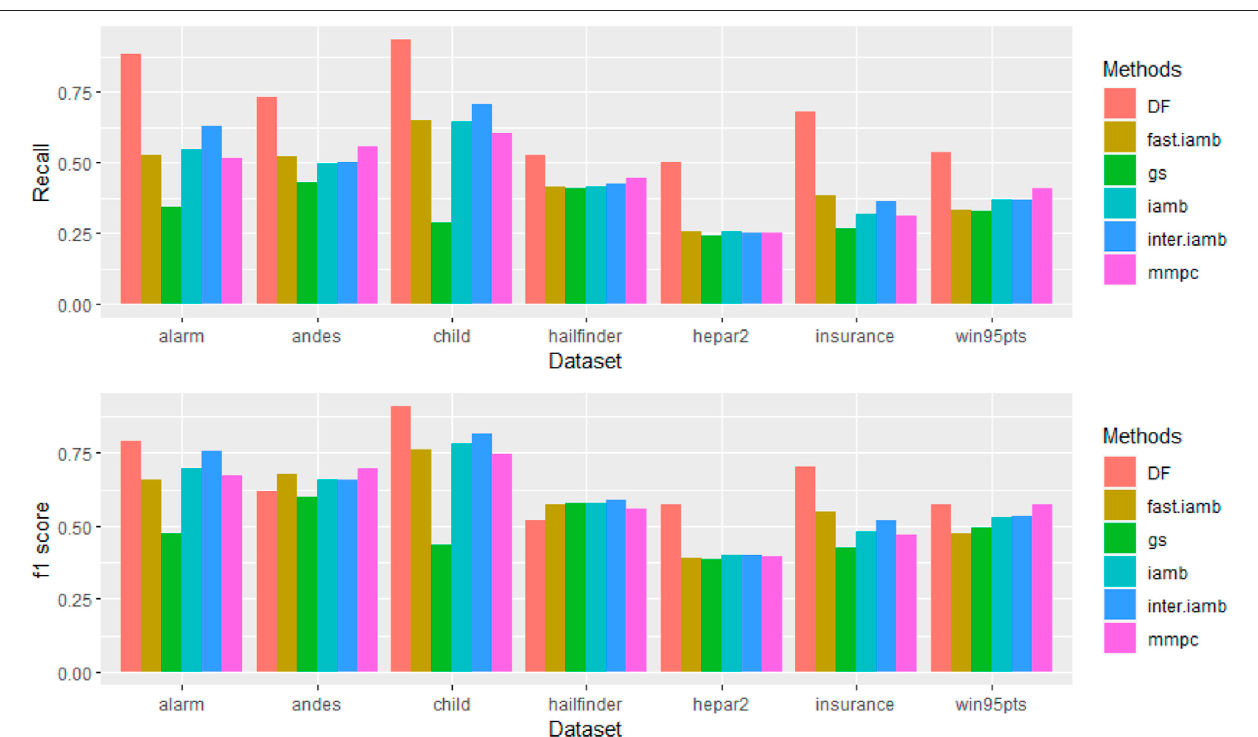
FIGURE 2 | Recall and f1 score of different methods with observation size 1,000. One can see that DF generally has higher recalls with higher or comparable F1- scores for the same network.